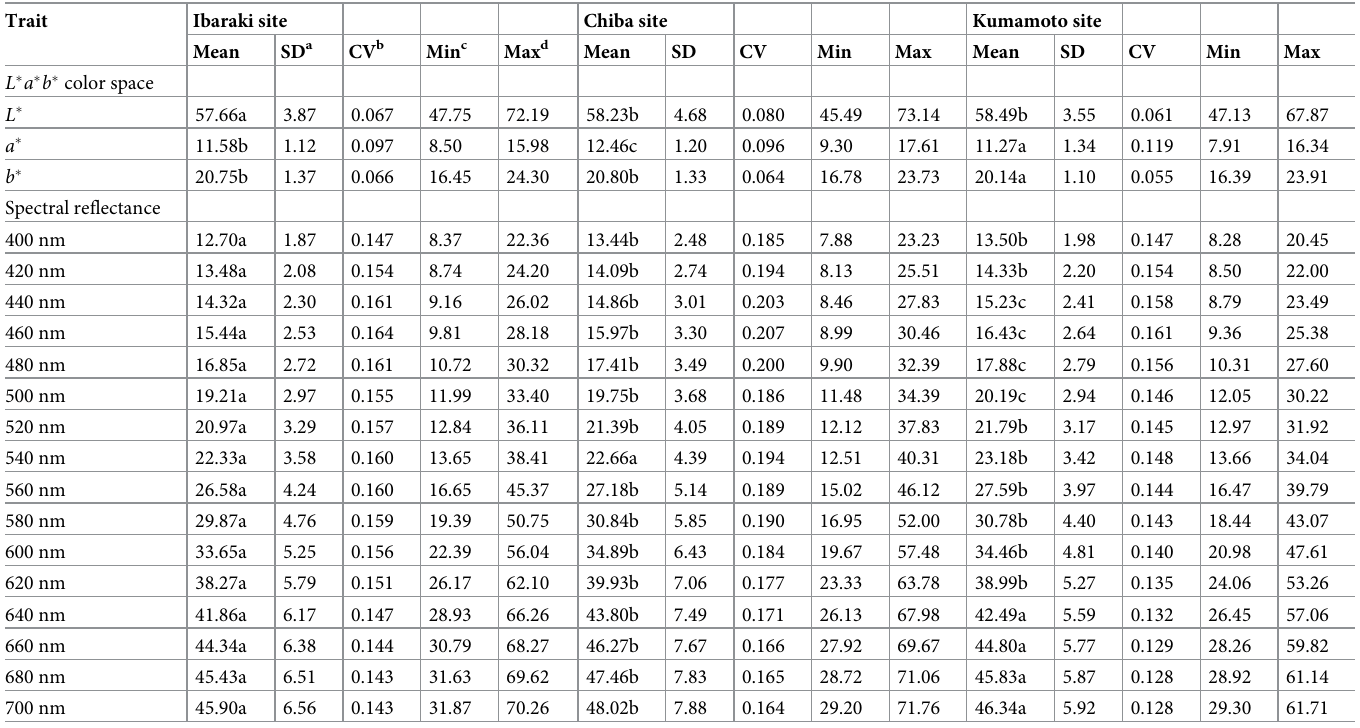
Table 1. Summary of the heartwood color traits in the three common gardens. Trait Ibaraki